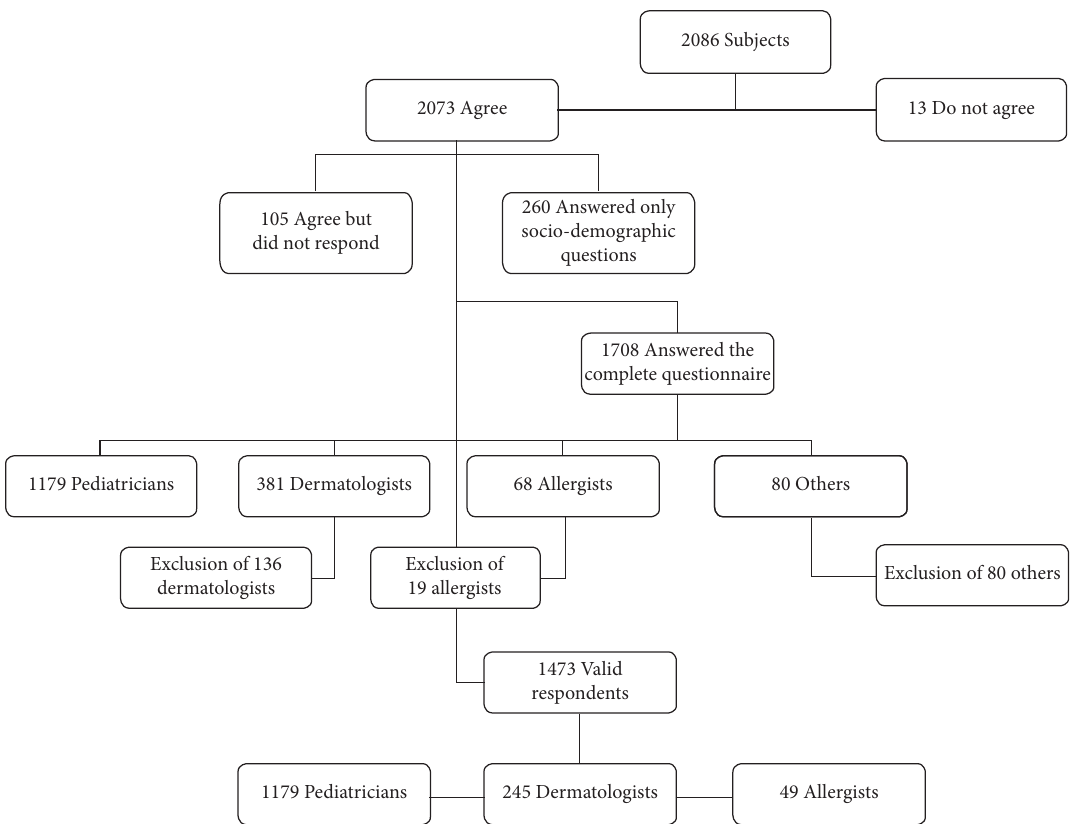
Figure 1: Flowchart of